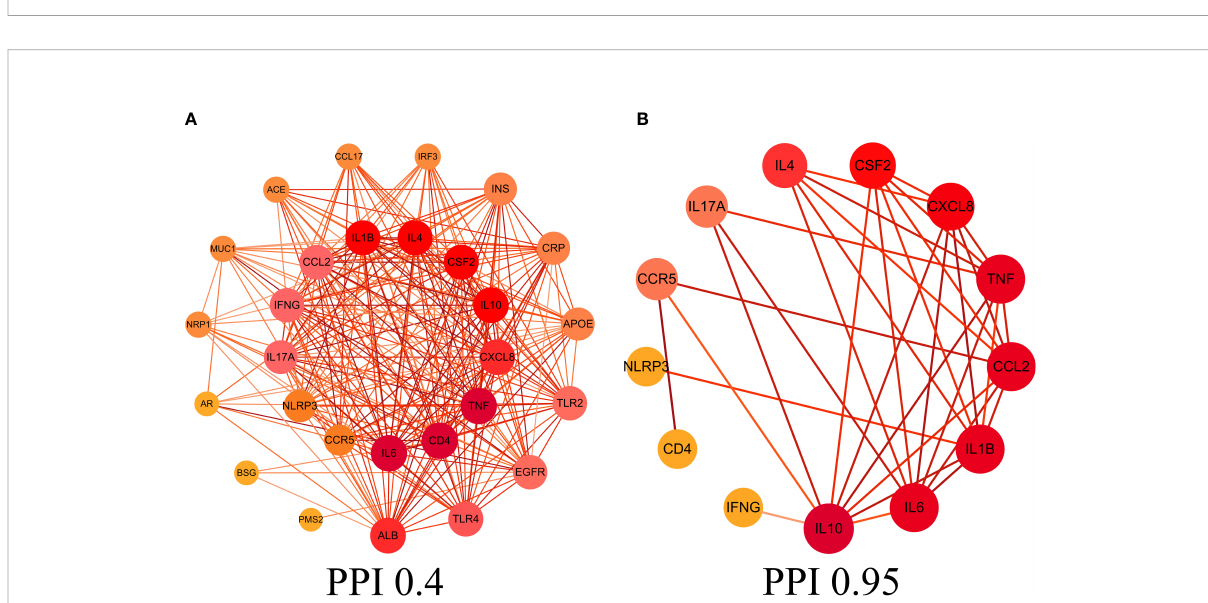
FIGURE 2 Protein-protein interaction (PPI) network. (A) PPI network of protein targets, (B) PPI network of core protein targets (con fi